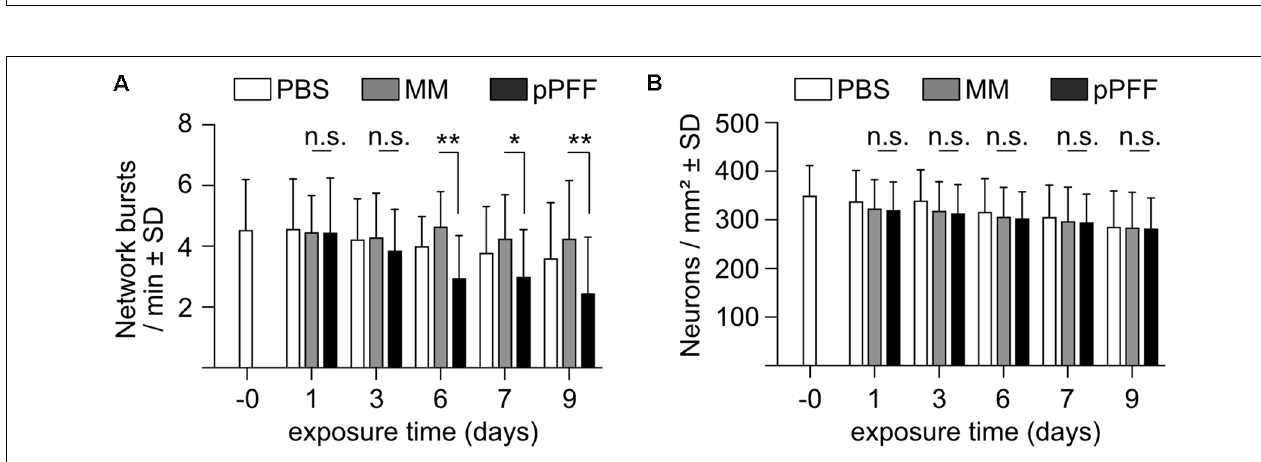
FIGURE 4 | Impact of naturally secreted extracellular α -Syn on network burst activity of native neurons. (A) Schematic depiction of the experimental layout. α -Syn expressing/secreting neurons were cultured alongside native neurons, which only express NmC and GCaMP6f. At DIV 22, the cell culture supernatant of α -Syn expressing/secreting neurons was used to replace the cell culture supernatant of the native recipient neurons, which were then analyzed for their network activity up to DIV 31. (B) Network bursts per minute are shown for recipient neurons that received α -Syn-containing medium on DIV 22 (white bars) or were further maintained in native medium (dark gray bars). N = 12 independent neuronal cultures per condition. Statistics by unpaired, 2-tailed T-test. n.s. = not significant.